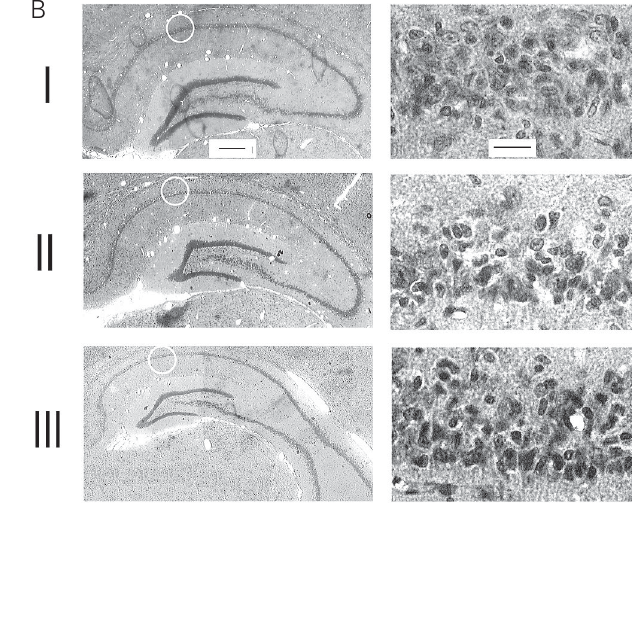
Figure 3. Photomicrographs of coronal sections of the hippo- campus at stereotaxic levels corresponding to -3.60 mm (I), -4.52 mm (II) and -5.30 mm (III) in rats subjected to sham operation (A), ischemia plus vehicle (B) or ischemia plus FK506 (C), at magnifications of 20X (left) and 400X (right). Hippocampal damage was assessed 7 days after ischemia. White circles (left panels) indicate the approximate location of the cell counts in the CA1 field. Intact-appearing pyramidal neurons are indicated by arrows. Bars = 100 µm (20X) and 20 µm